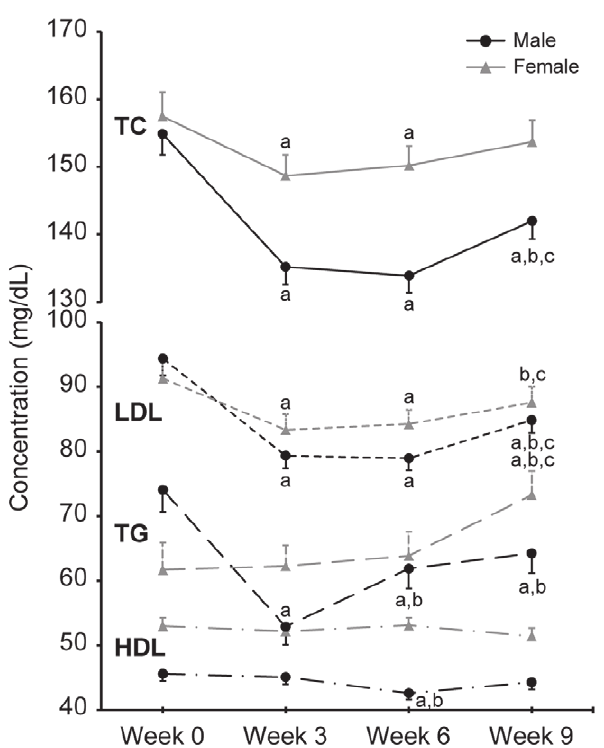
Figure 1. Effect of basic combat training on blood lipids and triglycerides. All values are mean 6 SEM; n=100M, 71F; TC, total cholesterol; LDL, low-density lipoprotein cholesterol; HDL, high-density lipoprotein cholesterol; TG, triglycerides. Two-factor mixed model repeated measures ANOVA. Sex-by-time interaction observed for all biomarkers, P , 0.05. Different from a week 0, b week 3, c week 6, P , 0.05.